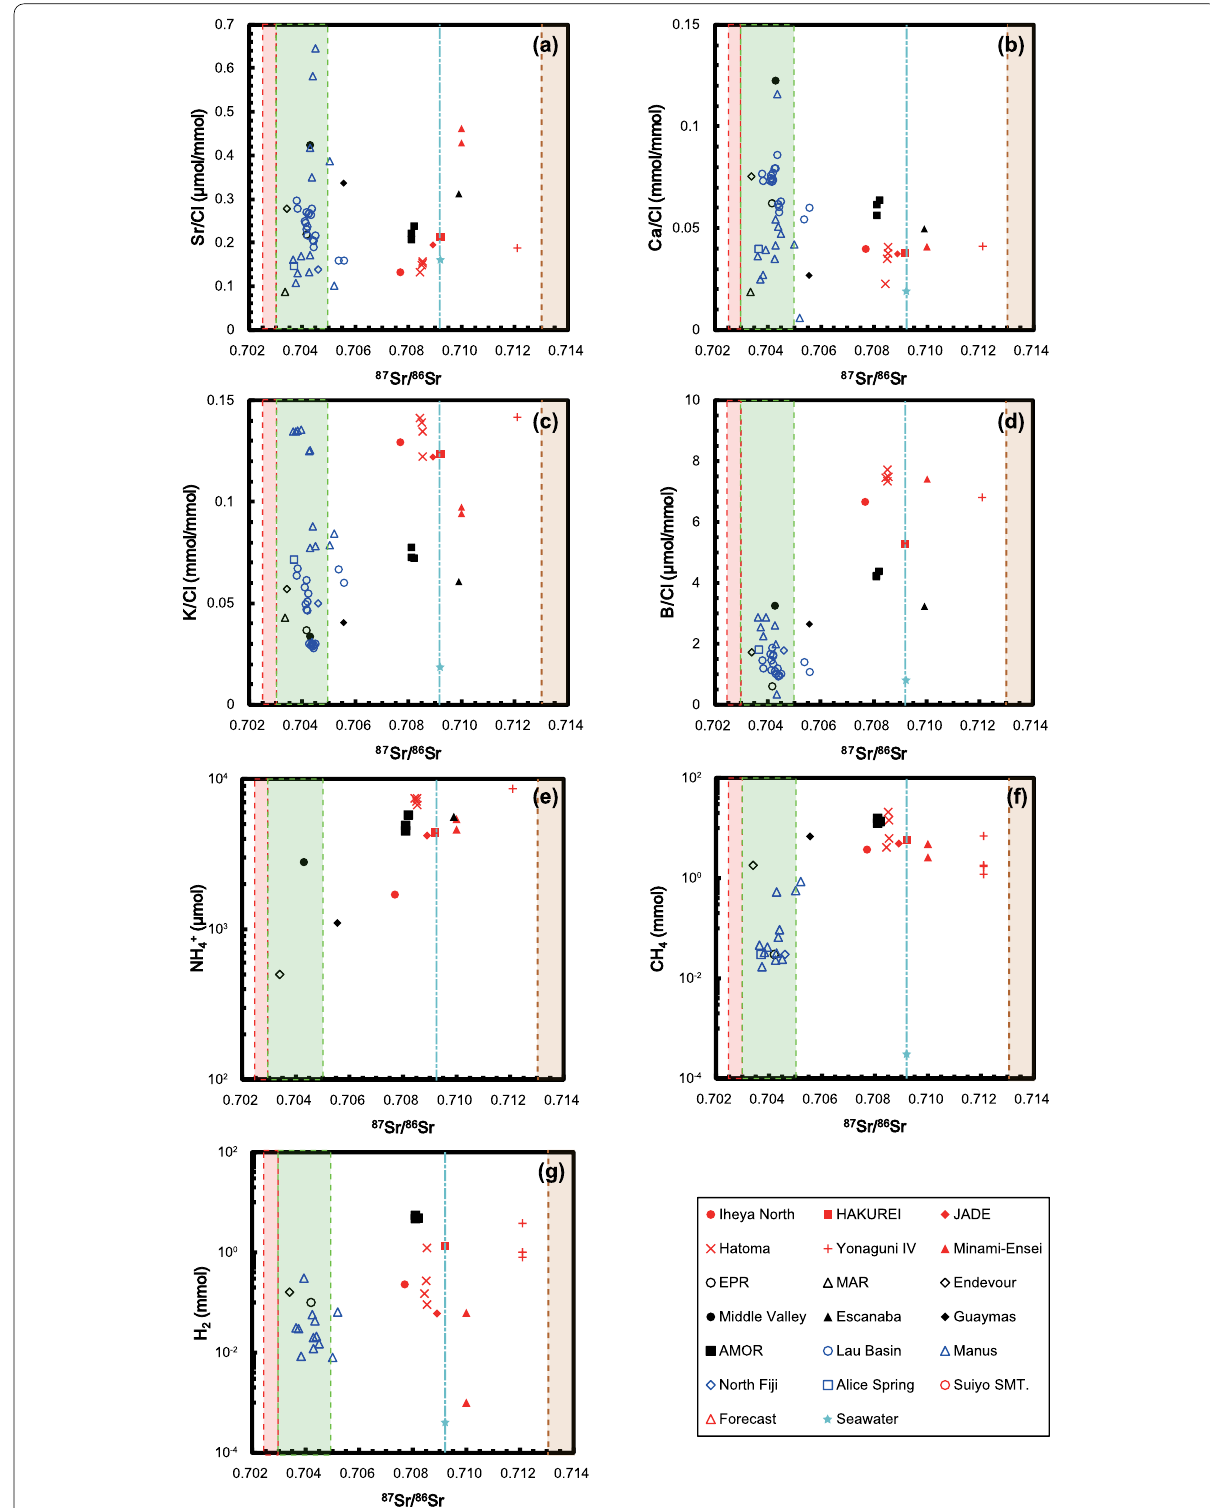
Fig. 5 Relationships between endmember Sr isotopic ratios in the Okinawa Trough hydrothermal fluids in this study and the concentration ratios of a Sr/Cl, b Ca/Cl, c K/Cl, d B/Cl, e NH 4 + , f CH 4 , and g H